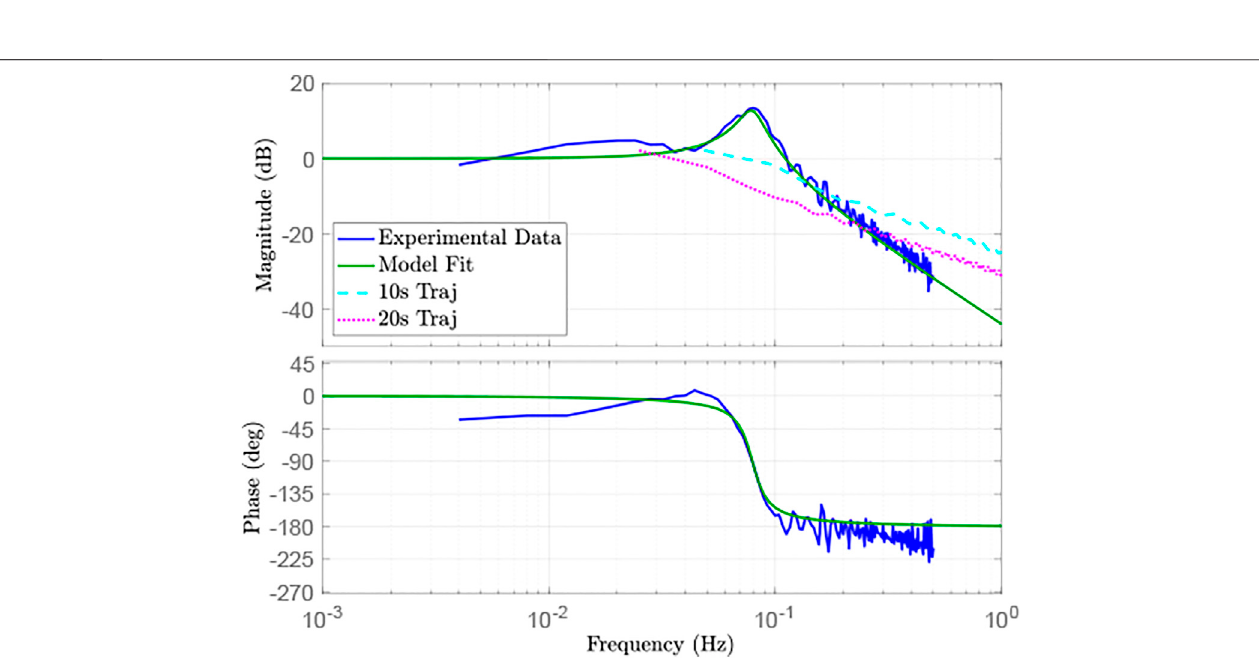
FIGURE 10 | Frequency response of model fi t, experimental data, and motor trajectories.